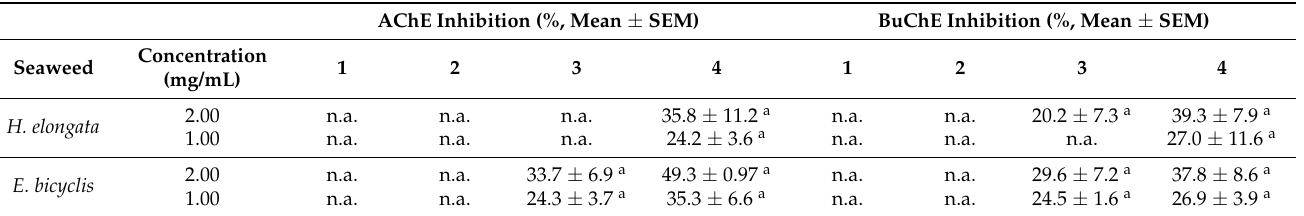
Table 4. AChE and BuChE inhibition (%) of SWE of Himanthalia elongata (L.) S.F.Gray and Eisenia bicyclis (Kjellman) Setchell. AChE Inhibition (%, Mean ±